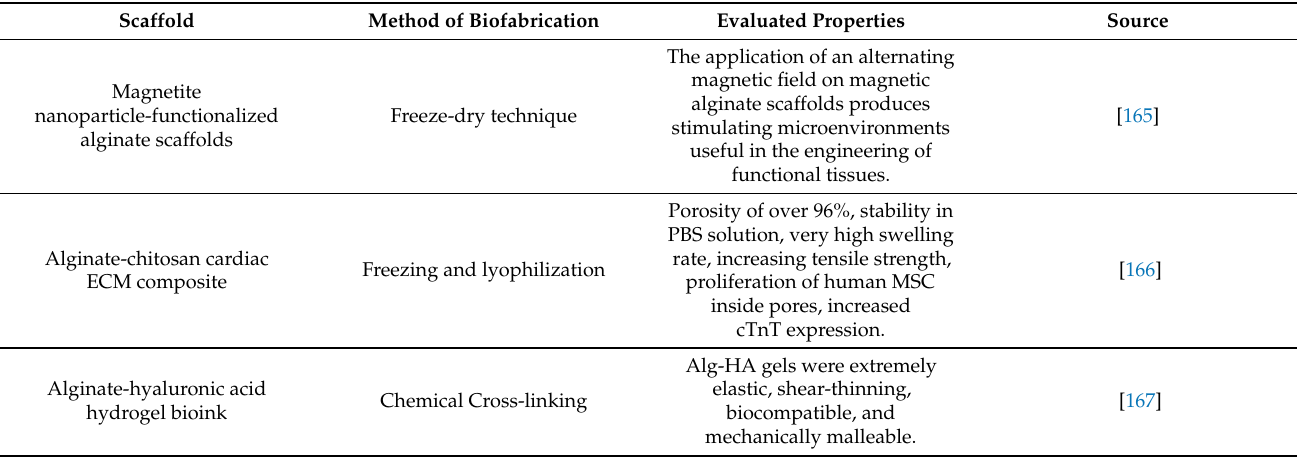
Table 4. Alginate-based scaffolds for heart tissue